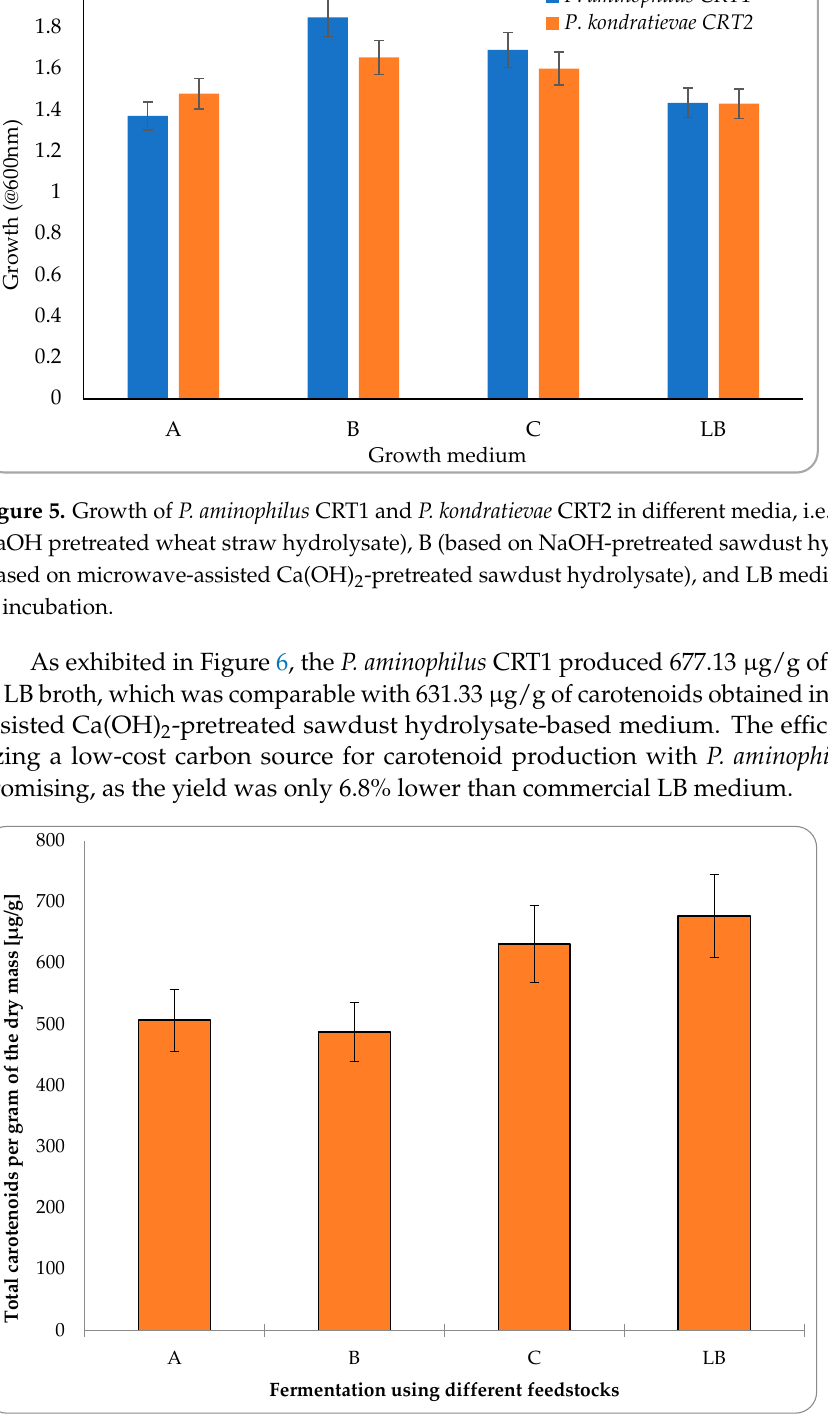
Figure 6. Total carotenoids achieved using P. aminophilus CRT1 cultivated in different media: A (based on NaOH-pretreated wheat straw hydrolysate), B (based on NaOH-pretreated sawdust hydrolysate), C (based on microwave-assisted Ca(OH) 2 -pretreated sawdust hydrolysate), and LB (Luria Bertani broth medium) after 72 h of incubation.